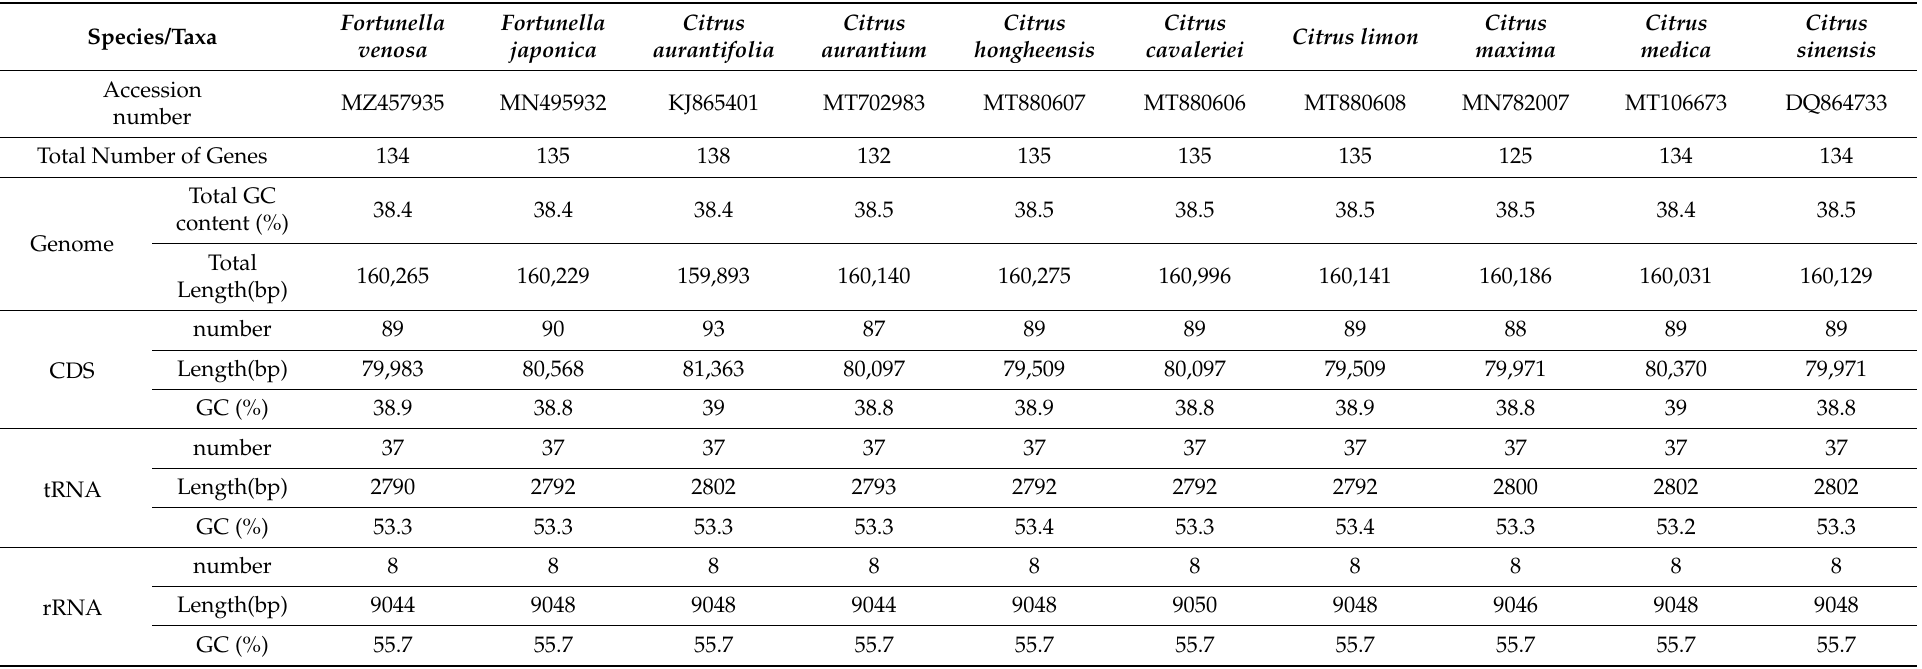
Table 1. Summary of complete chloroplast genomes for ten Rutaceae